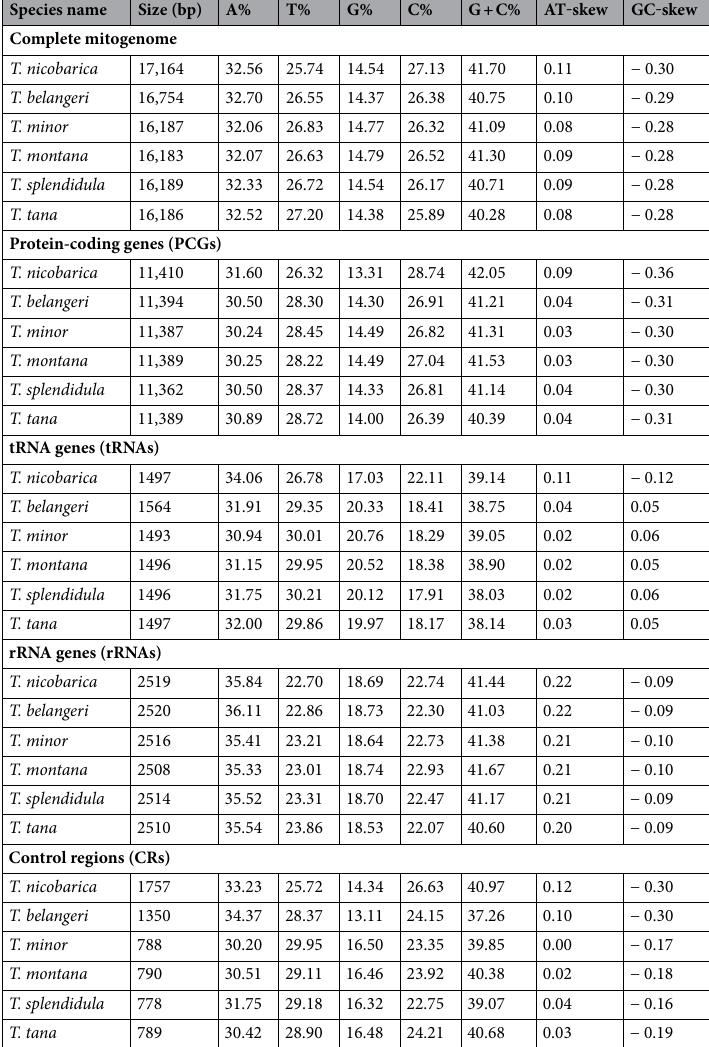
Table 2. Nucleotide composition of the mitochondrial genomes of different treeshrew mtDNA. The A + T biases of the complete mitogenome, PCGs, tRNAs, rRNA, and CRs were calculated by AT ‐ skew = (A − T)/ (A + T) and GC ‐ skew = (G − C)/(G + C),